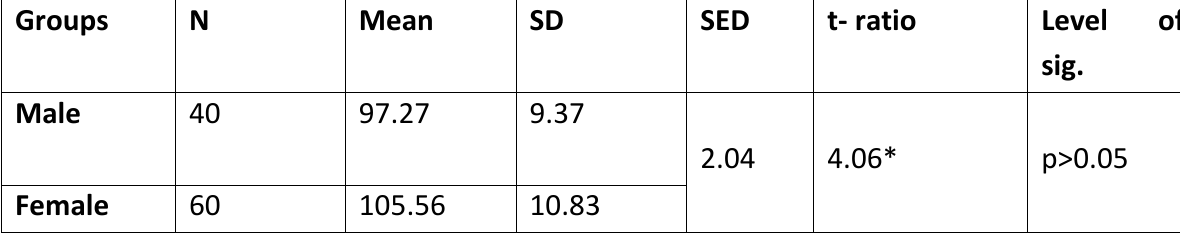
Table 4: Significance Difference in the Mean Score of Male and Female Secondary Teacher Trainees Attitude towards Entrepreneurial